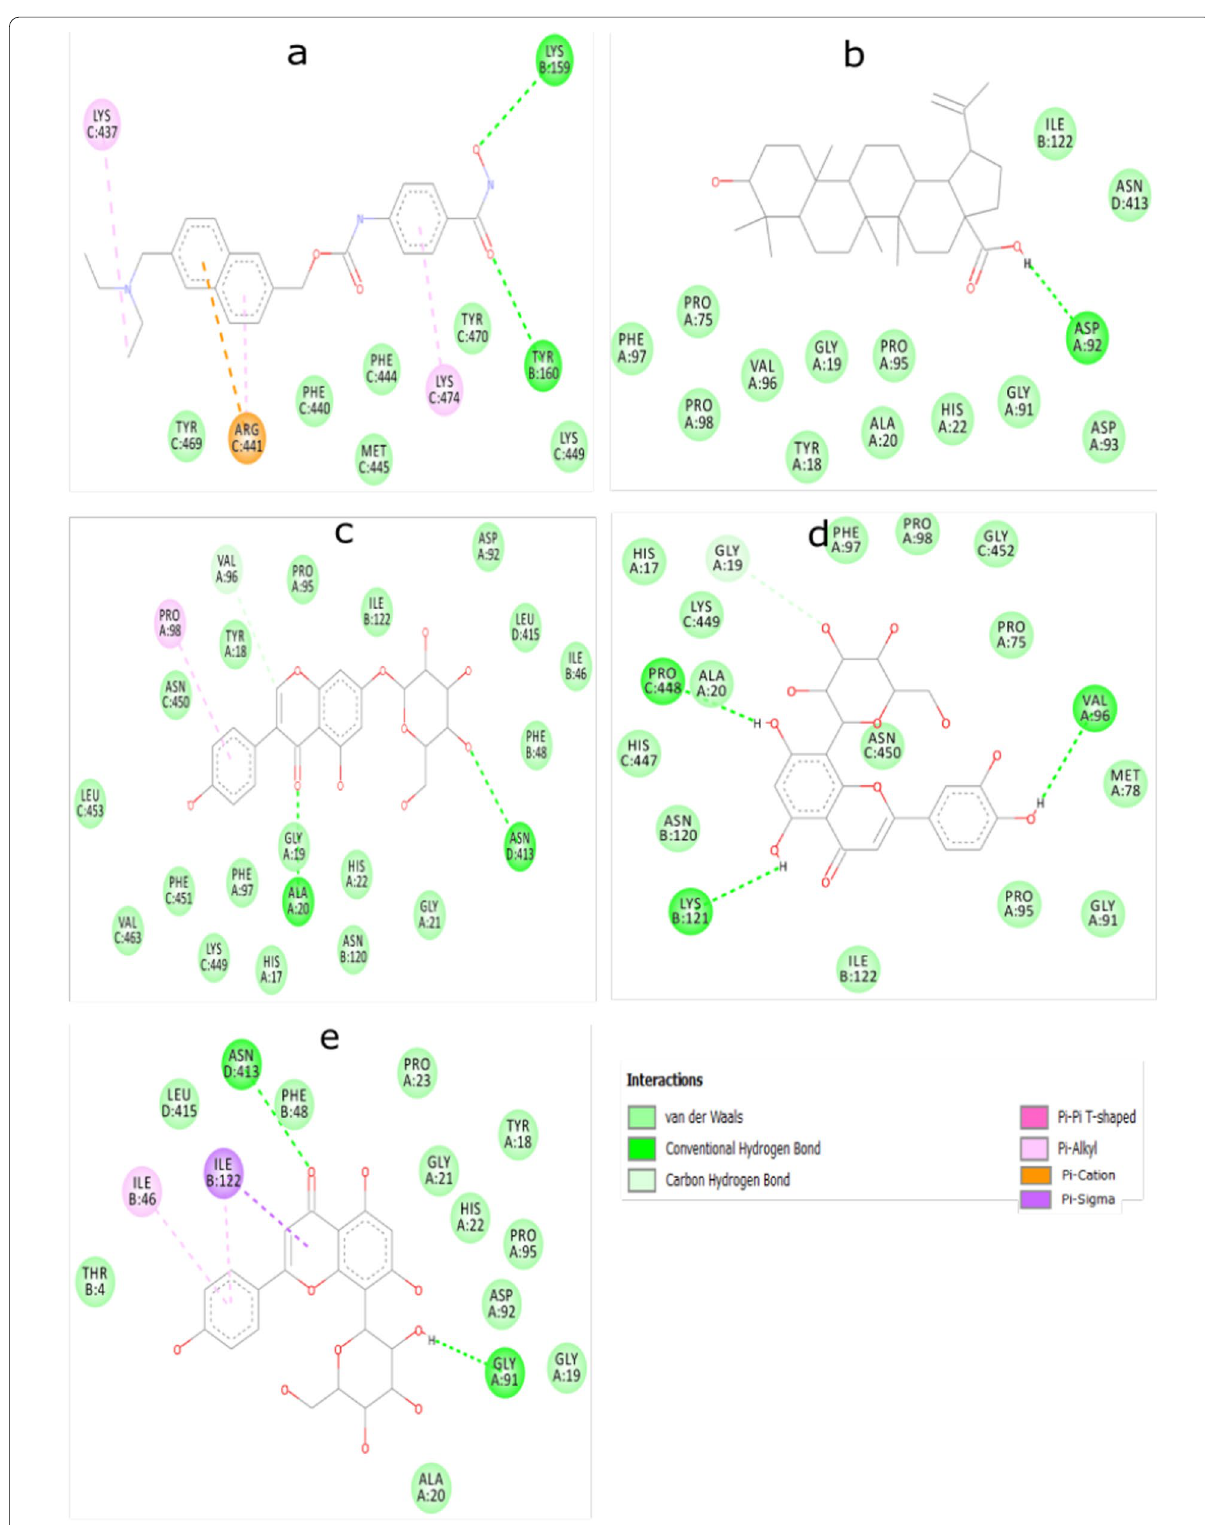
Fig. 4 2D view of the interaction between a givinostat b betulinic acid c genistin d orientin e vitexin and amino acids in the binding sites in histone deacetylase